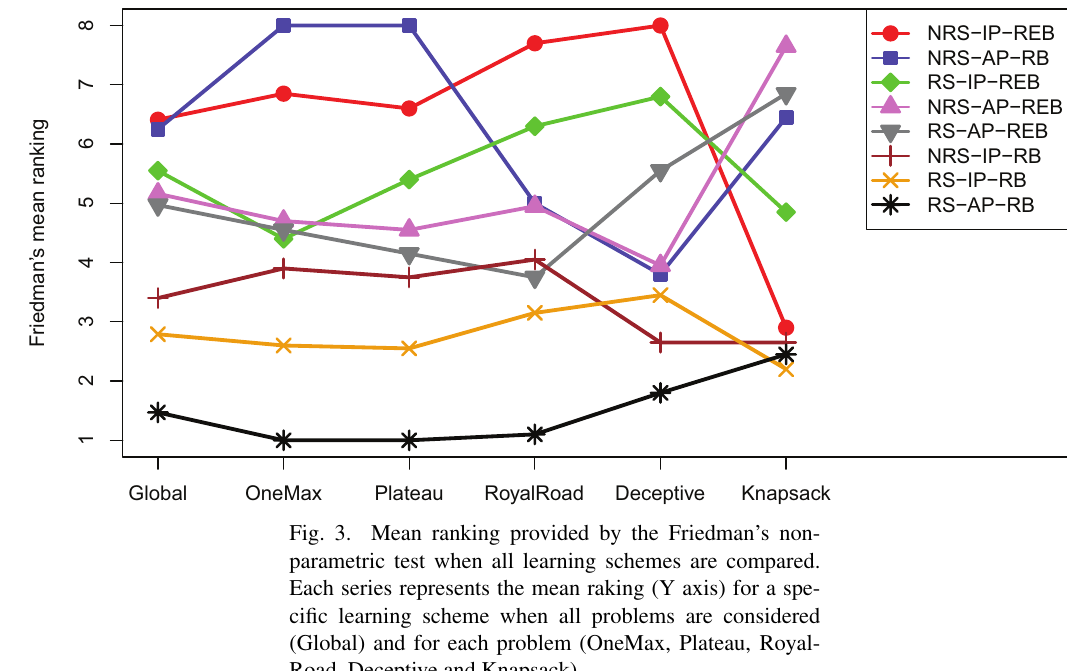
Fig. 3. Mean ranking provided by the Friedman’s non- parametric test when all learning schemes are compared. Each series represents the mean raking (Y axis) for a spe- cific learning scheme when all problems are considered (Global) and for each problem (OneMax, Plateau, Royal- Road, Deceptive and